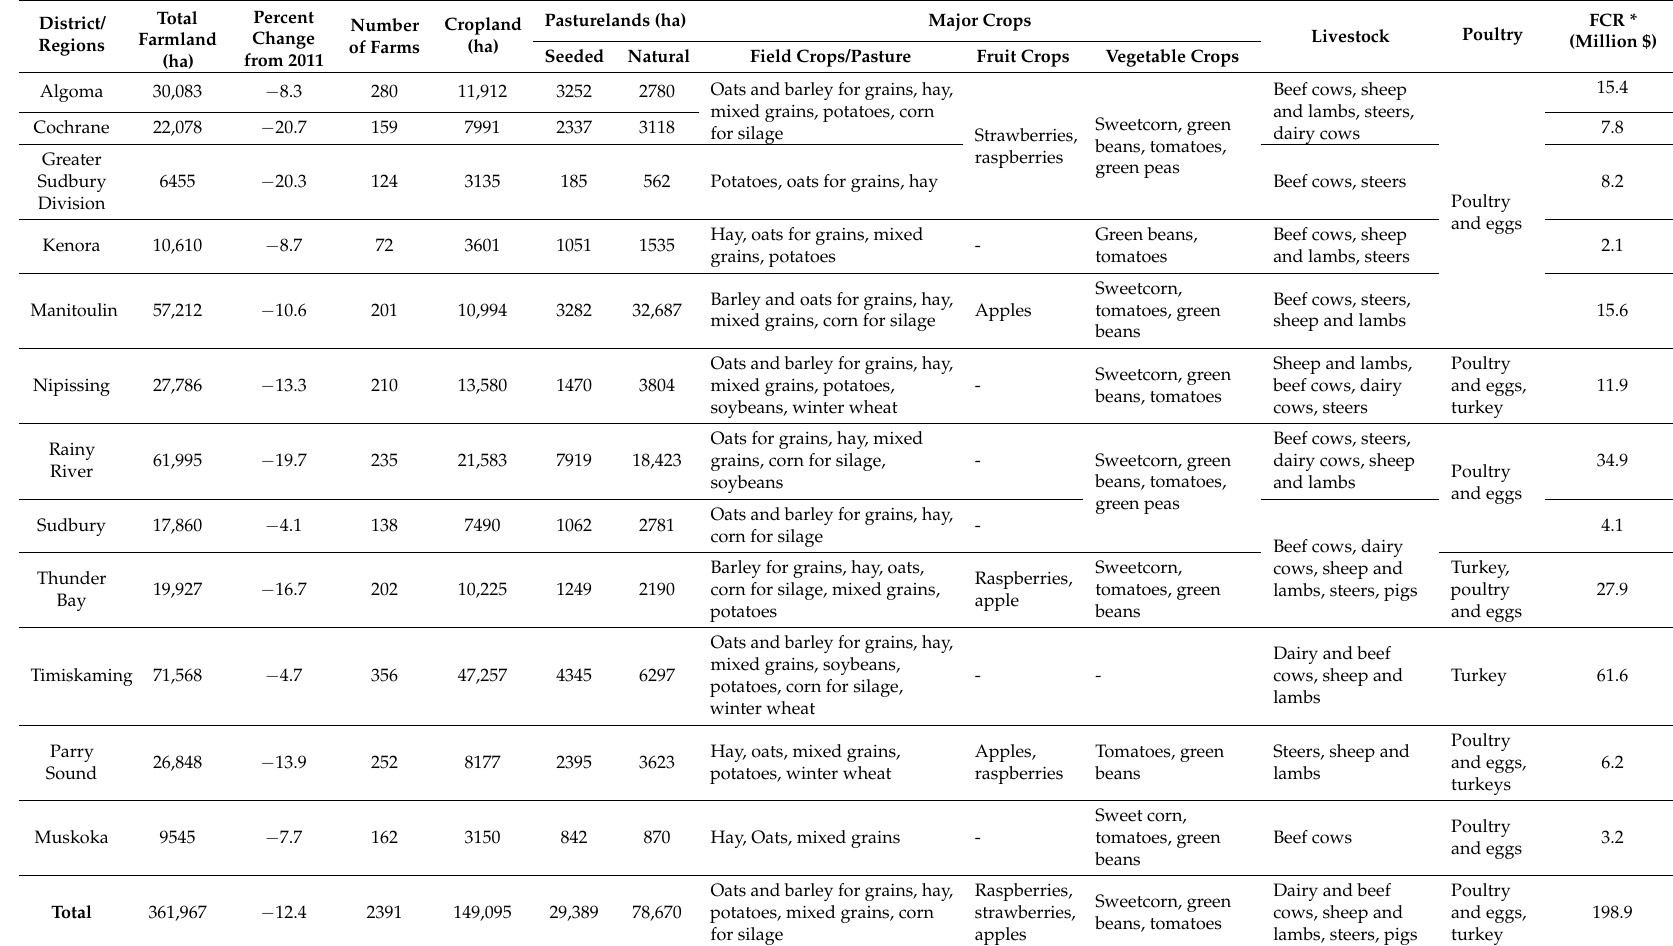
Table 1. Agriculture in Northern Ontario